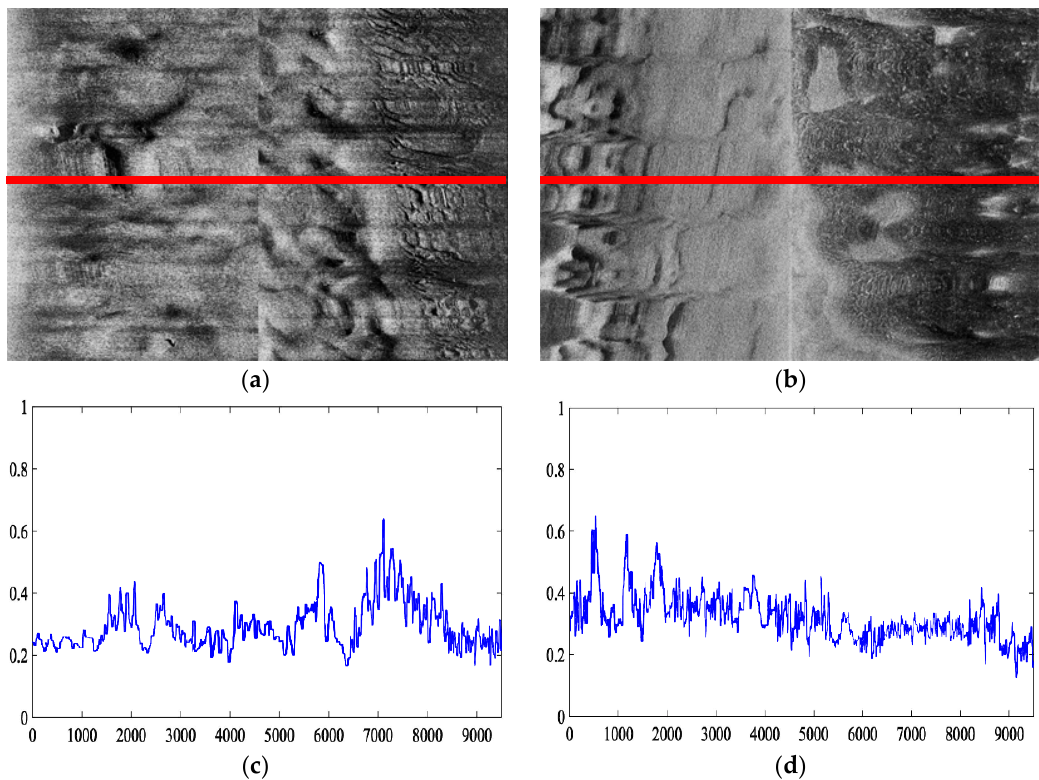
Figure 24. Example echo intensity in SSS imaging at the intersection of two AUV trajectories within the duration of more than one year. ( a ) SSS imaging in December 2019. ( b ) SSS imaging in January 2021. ( c ) Echo intensity curve regarding the ping in red on SSS imaging ( a ). ( d ) Echo intensity curve regarding the ping in red on SSS imaging ( b ). 8. Conclusions.